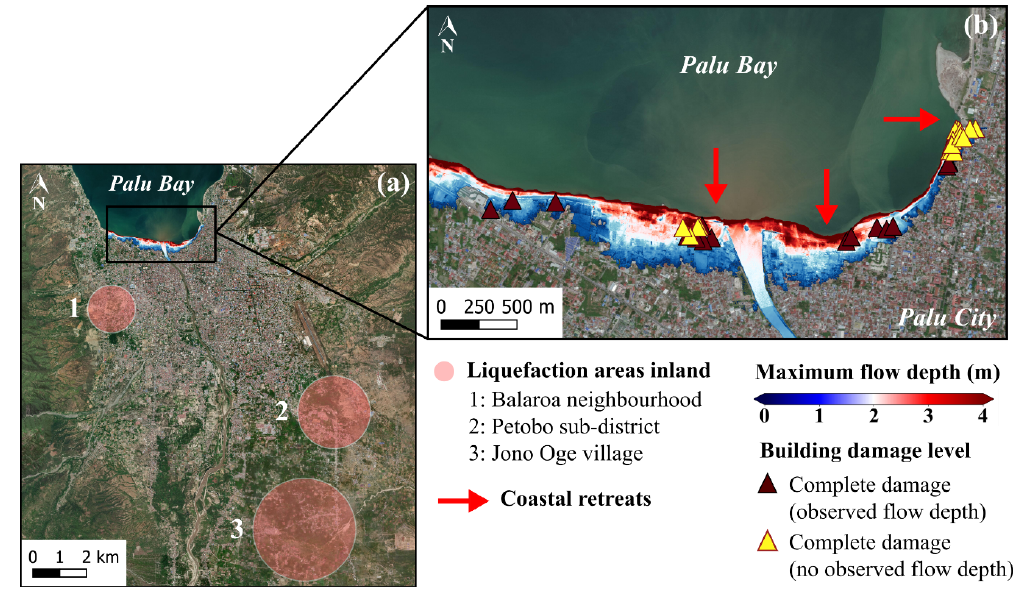
Figure 17. (a) Liquefaction areas surveyed inland near Palu City and (b) magnified view of the maximum simulated flow depth of the 2018 Sulawesi–Palu tsunami overlaid on the masonry-type buildings completely damaged ( ds 3 ) and location of the coastal retreats surveyed in the waterfront of Palu City (background